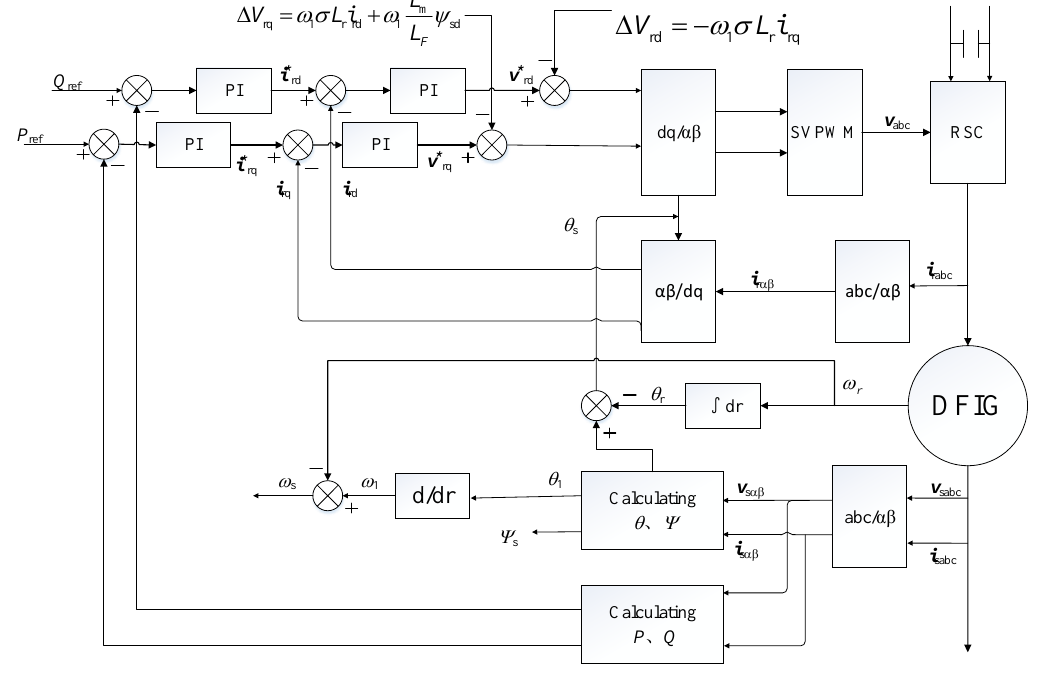
Figure 2. The control diagram of the RSC.